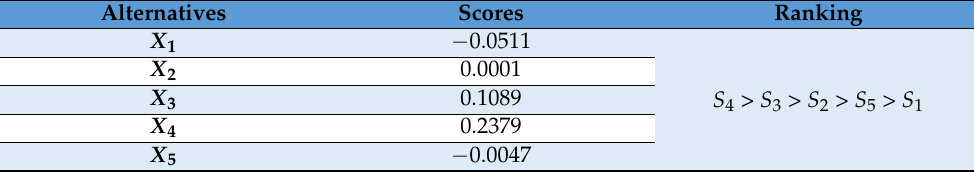
Table 10. The score values of the aggregated information. Alternatives Scores Ranking X 1 − 0.0511